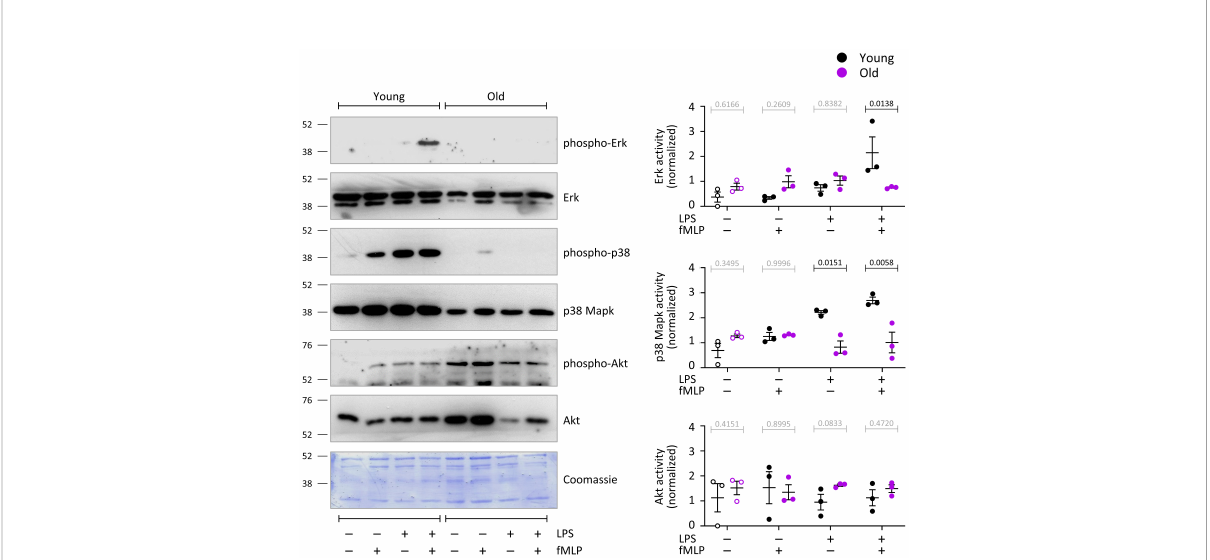
FIGURE 8 Hornigold K et al. LPS/TLR4 pathway activity is impaired in neutrophils from old mice. Neutrophils from young (8-10 weeks, black symbols) and old (24 months, purple symbols) mice were primed with 1 m g/ml LPS, or mock-primed with DPBS ++++ , and stimulated with 1 m M fMLP for 1 min. Total cell lysates were western blotted using antibodies for phosphorylated p38 Mapk, p42/44 Erk and Akt. Blots were stripped and reprobed for total p38 Mapk, p42/44 Erk and Akt. Blots were quantitated by ImageJ densitometry, and phospho-protein signals normalized to total-protein for each sample. Representative blots, and a coomassie-stained membrane as total loading control, are shown. Data are mean ± SEM of 3 independent experiments; each dot represents the mean of one experiment. Statistics are two-way ANOVA with Sidak ’ s multiple comparisons tests; black p-values are signi fi cant, grey p-values non-signi fi